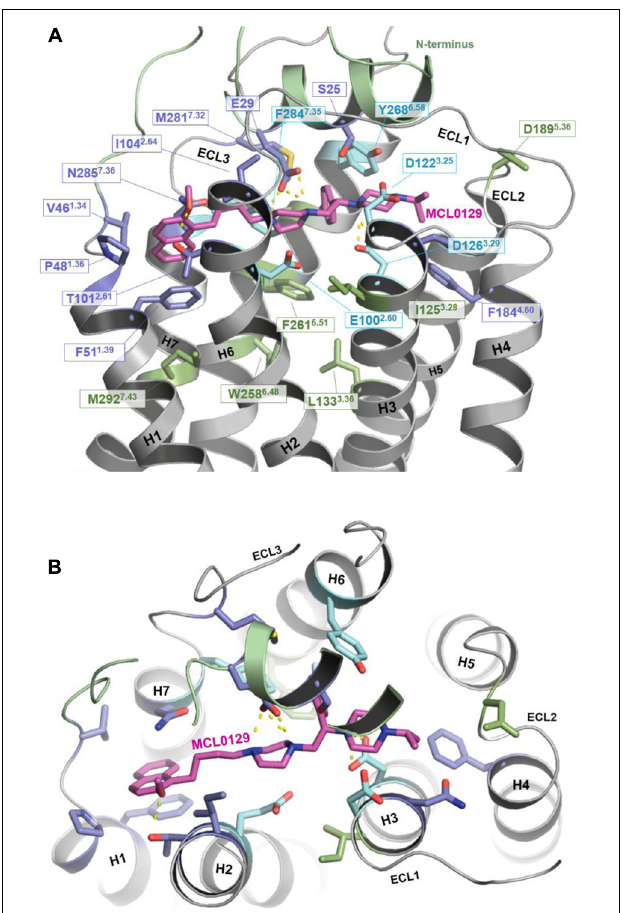
FIGURE 4 | Binding mode of MCL0129. (A) Side view showing MCL0129 in magenta and potentially contacting residues as blue and cyan sticks. Residues identified by mutagenesis to interact specifically with agonists are indicated in green. Those side chains reported to interact with agonist and overlap with here suggested MCL0129 interactions are indicated cyan. (B) Top view for the binding mode of MCL0129-hMC4R.